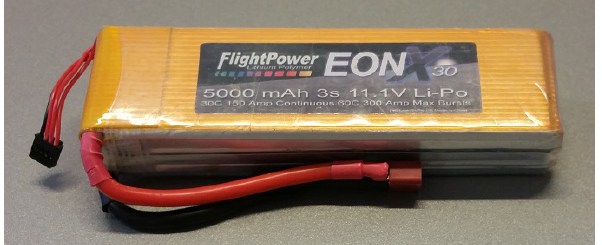
Figure 7: Battery used in the design validation